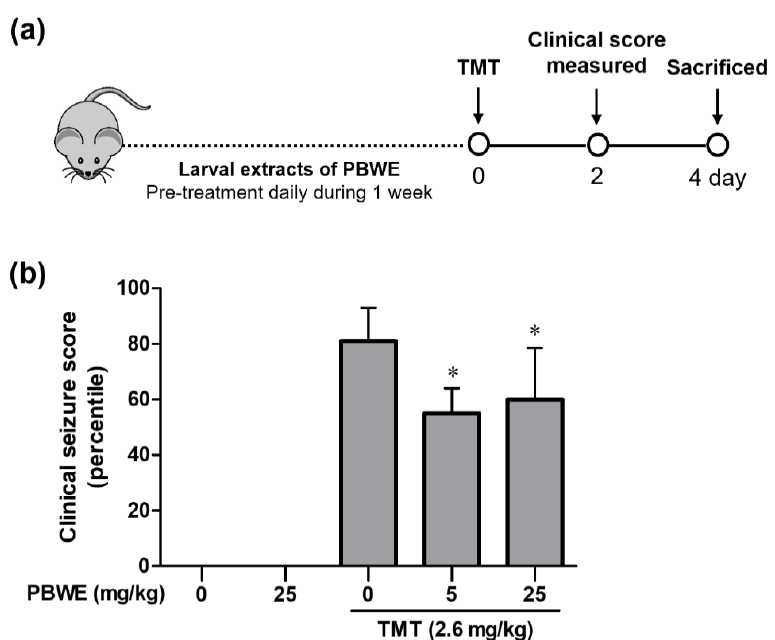
Figure 3. Protective effect of the Protaetia brevitarsis seulensis ’ water extract (PBWE) on seizure symptoms in trimethyltin (TMT)-treated mice. ( a ) Schematic diagram showing the timeline of drug administration, behavioral tests, and sacrifice. ( b ) PBWE pretreatment ameliorated TMT-induced seizure behaviors on day 2 ( n = 10 mice per group). Values are reported as median of percentile + interquartile. * p < 0.05 vs. TMT-alone treated group.